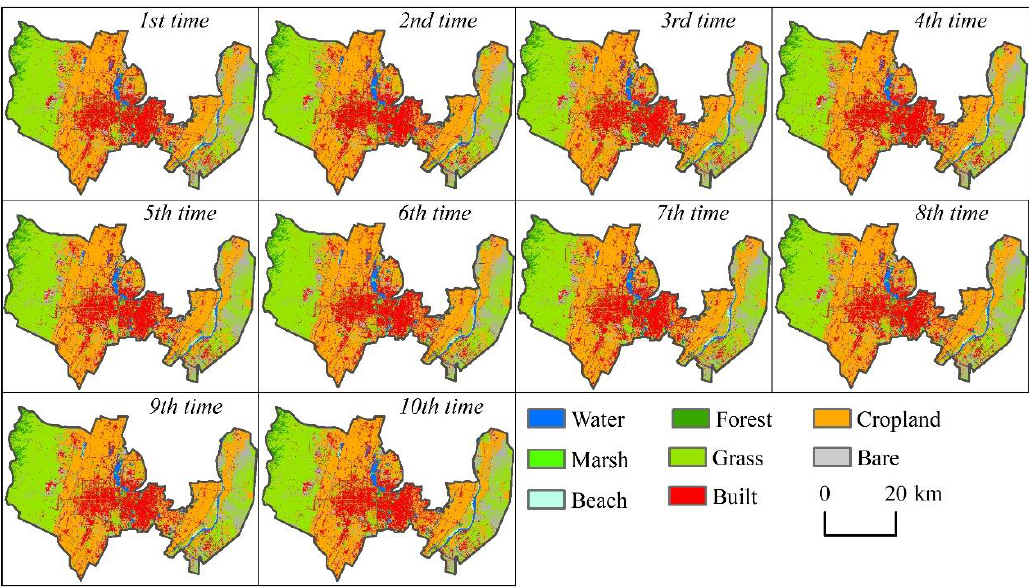
Figure A1. The ten times classification results of Yinchuan in 2020.